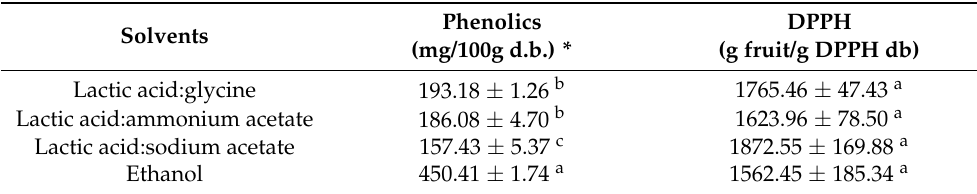
Table 2. Phenolic compounds and antioxidant potential of dragon fruit extracts obtained using NADESs and ethanol.